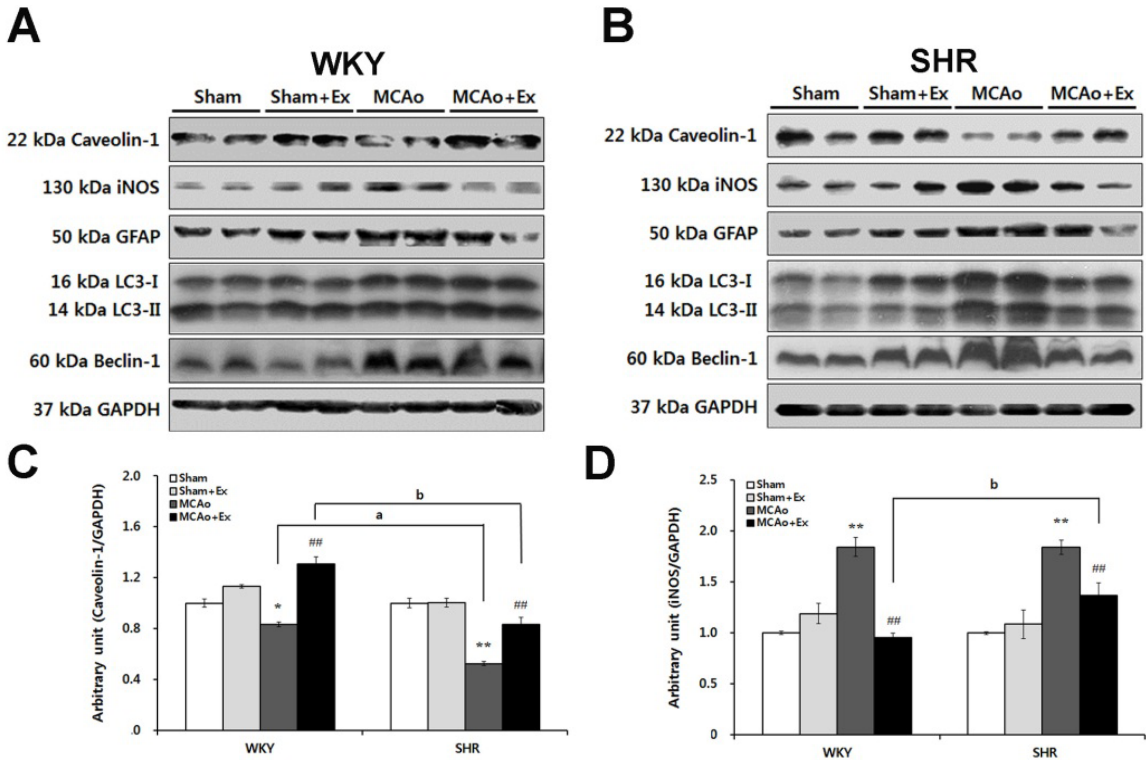
Figure 5. Effects of forced exercise on interaction of caveolin-1 and iNOS and autophagy signaling after focal cerebral ischemic injury. ( A ) Western blot analysis for caveolin-1, iNOS, glial fibrillary acidic protein (GFAP), and autophagy signaling in brain tissue of WKY rats and ( B ) SHR rats with MCAo surgery. ( C ) Caveolin-1 protein levels were down-regulated after MCAo, and they increased after exercise ( p < 0.05). ( D ) iNOS protein levels were increased in WKY and SHR rats after focal cerebral ischemia. SHR rats showed a larger increase in iNOS protein levels compared with that in WKY